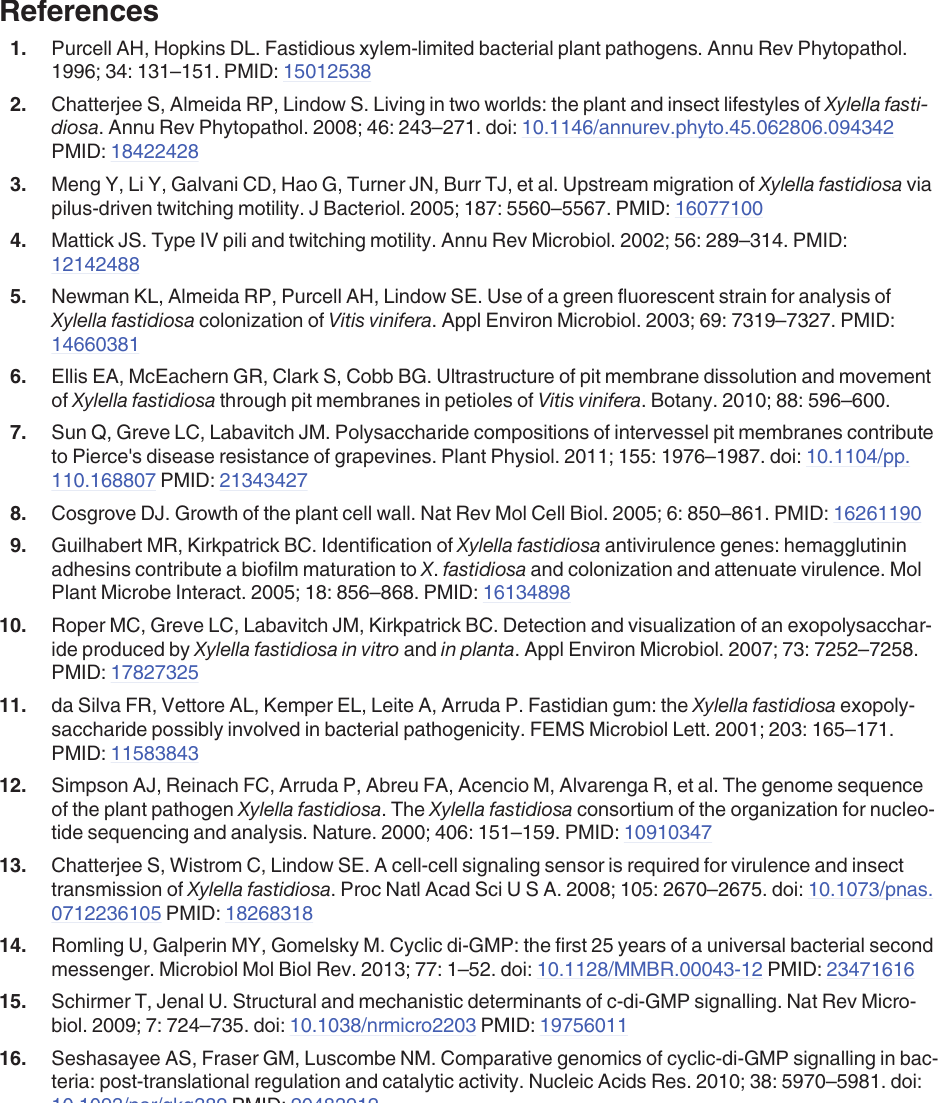
Fig. 1C. C ) EAL alignment. Grey/boxed residues match the signature EAL sequence and the underlined/bold residues line with the DDFGTG sequences as seen in Fig. 1D.